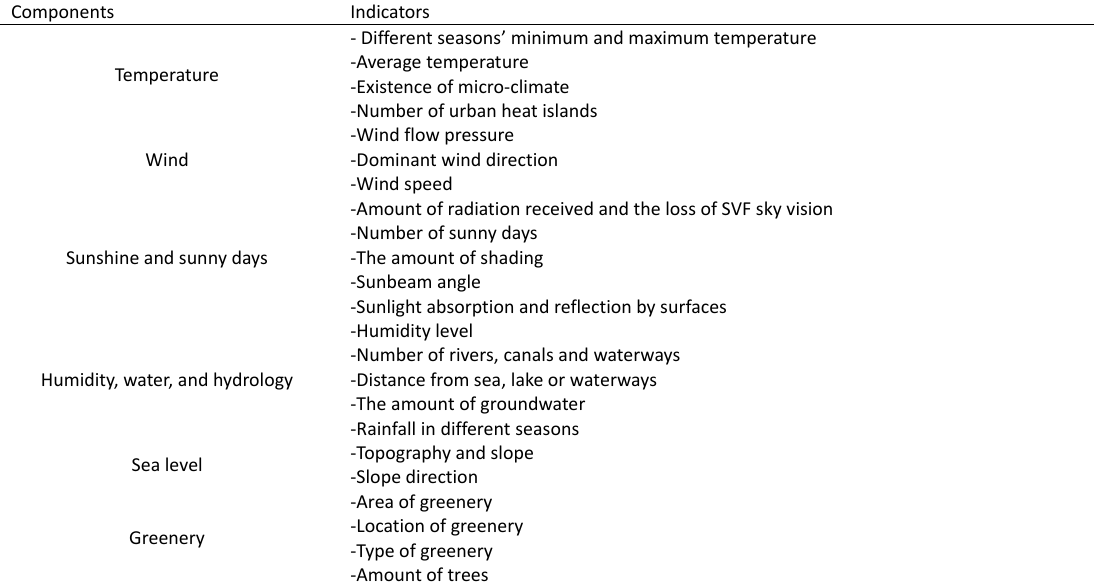
Table 3: Effective climate indicators on local scale